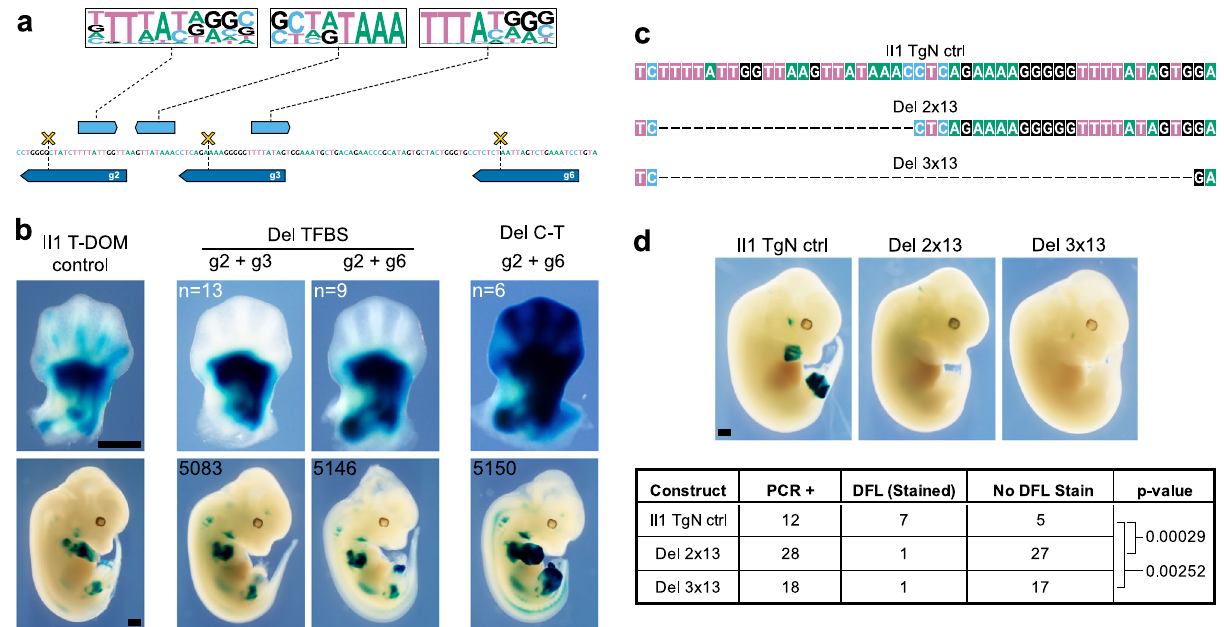
Fig. 4 The effects of deleting HOX13 binding sites. a On top are the HOX13 motifs in the II1 element, identi fi ed in Fig. 3b, with their positions indicated below (light blue boxes with orientations). The dark blue boxes below the DNA sequence indicate the positions and orientations of the CRISPR guides. Combinations of guides were used to generate small deletions (g2 + g3 or g2 + g6). The yellow crosses indicate the approximate cutting position of the Cas9. b E12.5 F0 LacZ stained embryos containing these deletions. The left panel is a II1 T-DOM control limb (no CRISPR cutting), with weak staining in the distal digit mesenchyme (dozens were stained). The two central panels are representative embryos (sample size n indicated in upper left corners) with the indicated deletions (see Supplementary Fig. 4-1 for images of all embryos including these two #5083 and #5146). Embryos carrying either the g2 + g3 or g2 + g6 deletions lost all staining in distal limb cells. In the same litters, we observed some embryos with strong distal limb staining (as shown in the right panel, see also Supplementary Fig. 4-1b, c). They contained a deletion that extends from the native II1 element in C-DOM to the II1 transgenic element in T- DOM, due to the guide RNA sequence presence at both sites (scheme in Supplementary Fig. 4-1c). Deletions in all embryos were sequenced (Supplementary Data 2). Embryos with ambiguous sequencing results or mosaicism were not used in this analysis. c DNA sequence, mapping to the putative HOX13 binding sites in the II1 enhancer elements (see a ). II1 transgenic embryos were generated using these variants as the transgenic material. The top track is the wild-type sequence used in control embryos (II1 TgN ctrl). The Del 2 × 13 sequence lacks the two centromeric motifs (see a ), while the Del 3 × 13 sequence lacks all three motifs for putative HOX13 binding. d On top are LacZ stained E12.5 transgenic embryos, the table below reports the number of embryos positive for the transgene by PCR (PCR + ), the second column is the number of embryos that stained in the distal forelimb (DFL), followed by the embryos with no staining in the DFL (No DFL Stain). The p values are determined by two-sided Fisher ’ s exact tests. Representative embryos are shown for each transgene. See also Supplementary Fig. 4-2. Scale bars are 0.5